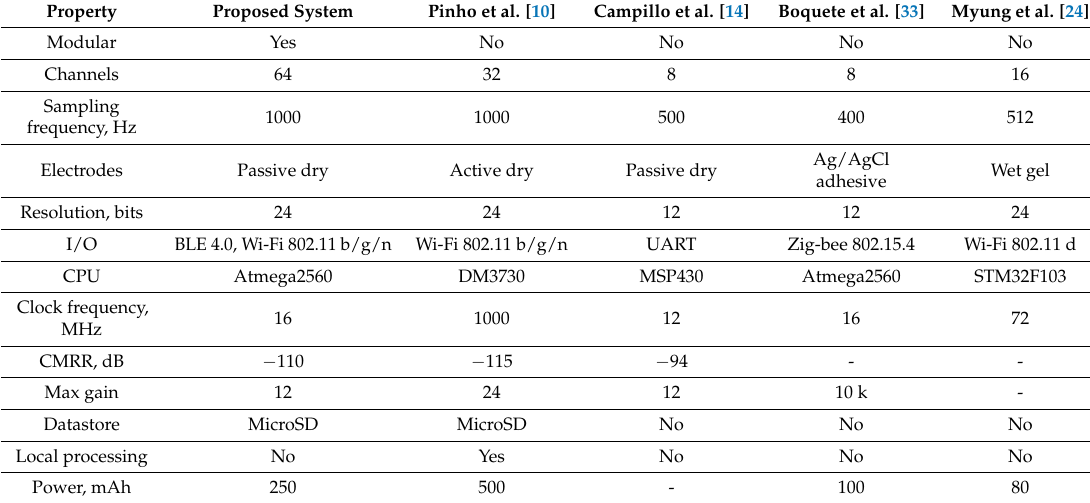
Table 6. Comparison with existing